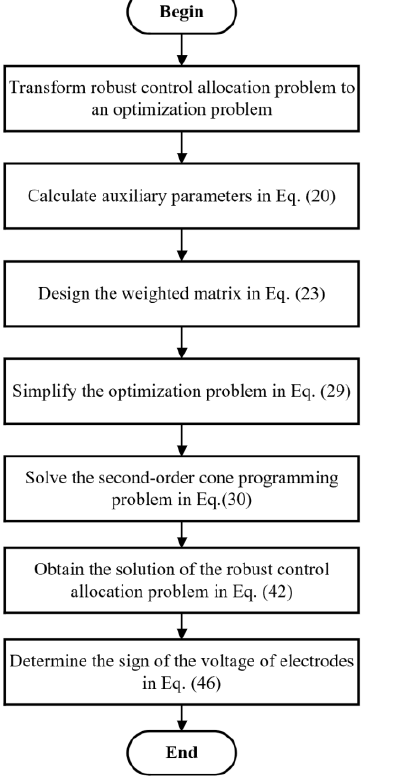
Figure 4. Flow chart of the proposed robust control allocation algorithm.